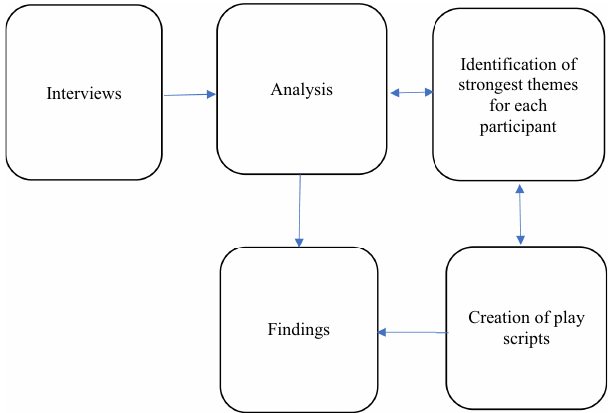
Figure 1. The research